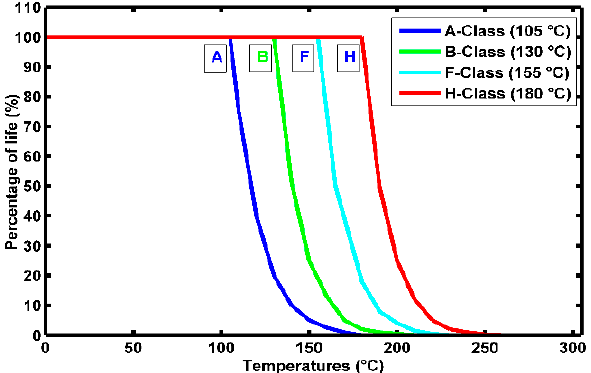
Figure 3. Aging factor of motor insulation for classes A, B, F, and H [15].